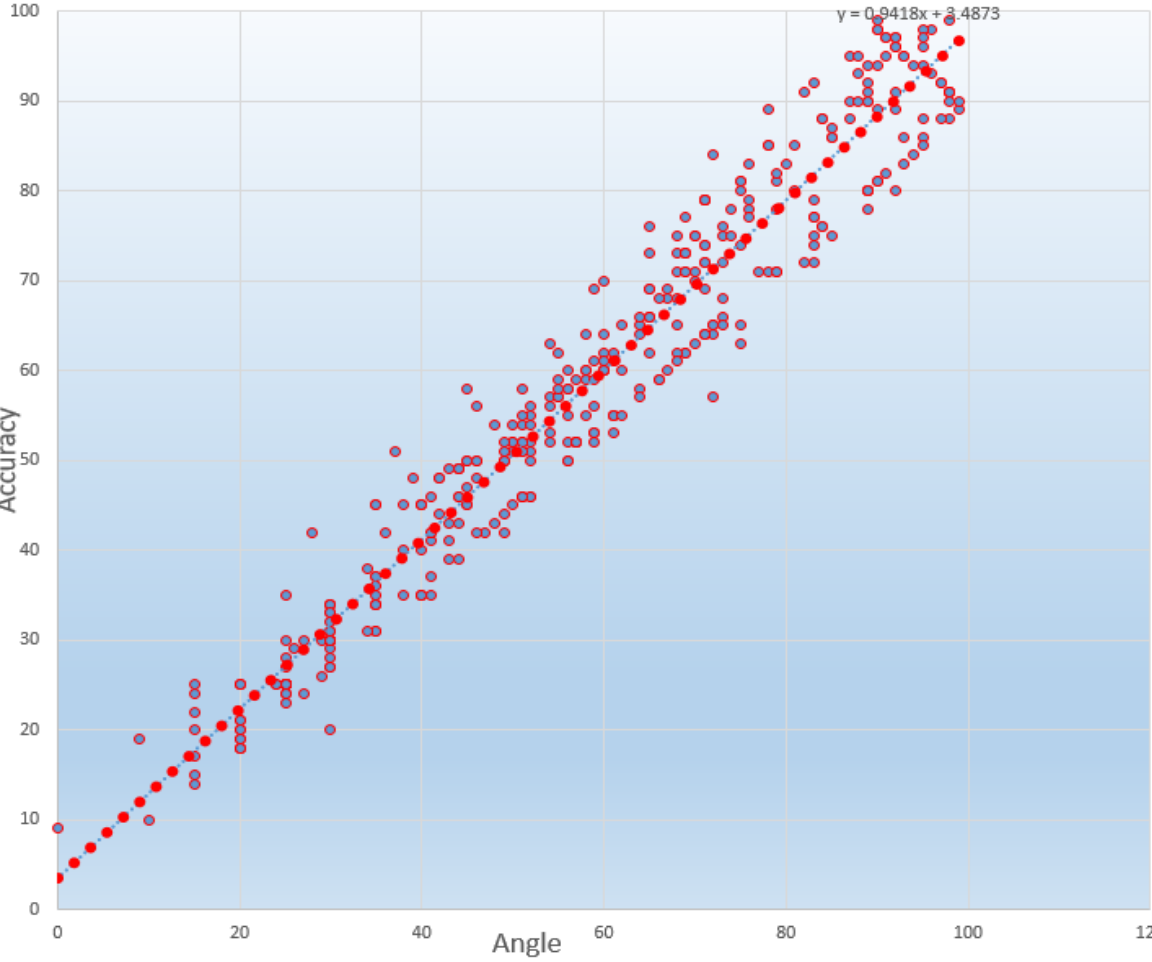
Figure 9. Modelling the reliability using linear regression on test datasets.